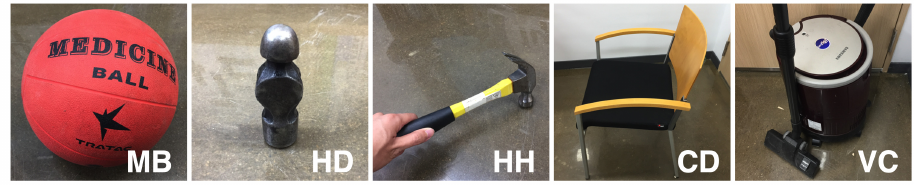
Figure 1. Five noise types included in the datasets. Reprinted